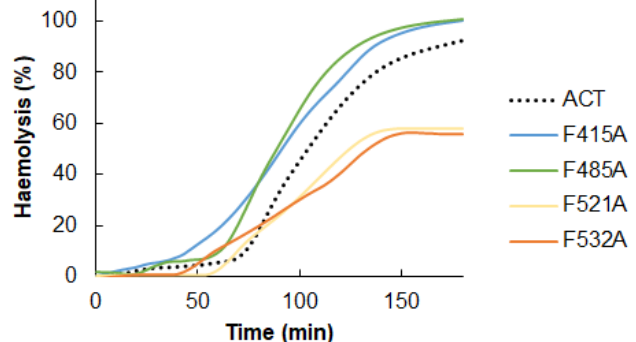
Figure 5. Effect of Ala substitutions in the central Phe residues of the potential cholesterol-binding sites CRAC 415 , CARC 485 , CRAC 521 and CARC 532 on the kinetics of the ACT-induced haemolysis. Raw traces of the kinetics recorded from a representative experiment of the haemolysis induced by intact ACT (50 nM) or by each one of the four mutant toxins (50 nM). A suspension of sheep erythrocytes (5 × 10 8 cells/mL) was incubated with each protein for 180 min at 37 °C, recording the scattering changes measured at 700 nm at every second. Then the haemolysis percentage was calculated as detailed in the Experimental Procedures section and depicted in the figure. The traces shown correspond to a representative experiment from three experiments performed independently.